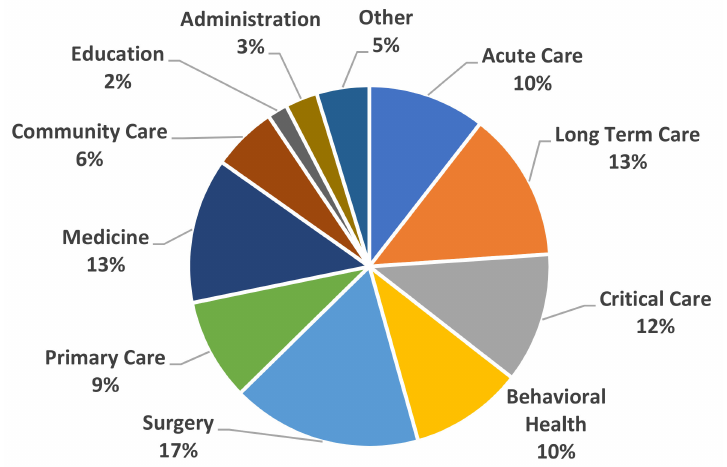
Figure 1. Survey participants by work unit. During the administration of this survey, an active vaccine rollout was in progress at the healthcare facility. Overall, 81.9% of participants ( n = 226) reported that they were willing to receive the vaccine during the initial rollout, 11.2% ( n = 31) were hesitant, and only 5.1% ( n = 14) were unwilling to receive the vaccine (Table 1). When assessing self- perceived risk of COVID-19 (Table 2), there was a higher than expected number of those who already had the disease (38.4%). Of those who did not report having COVID-19, most perceived their risk of contracting the disease as low, with 33.3% predicting that they would not get ill and 20.3% predicting a mild case (Table 2). Only 6.9% predicted that they would get seriously